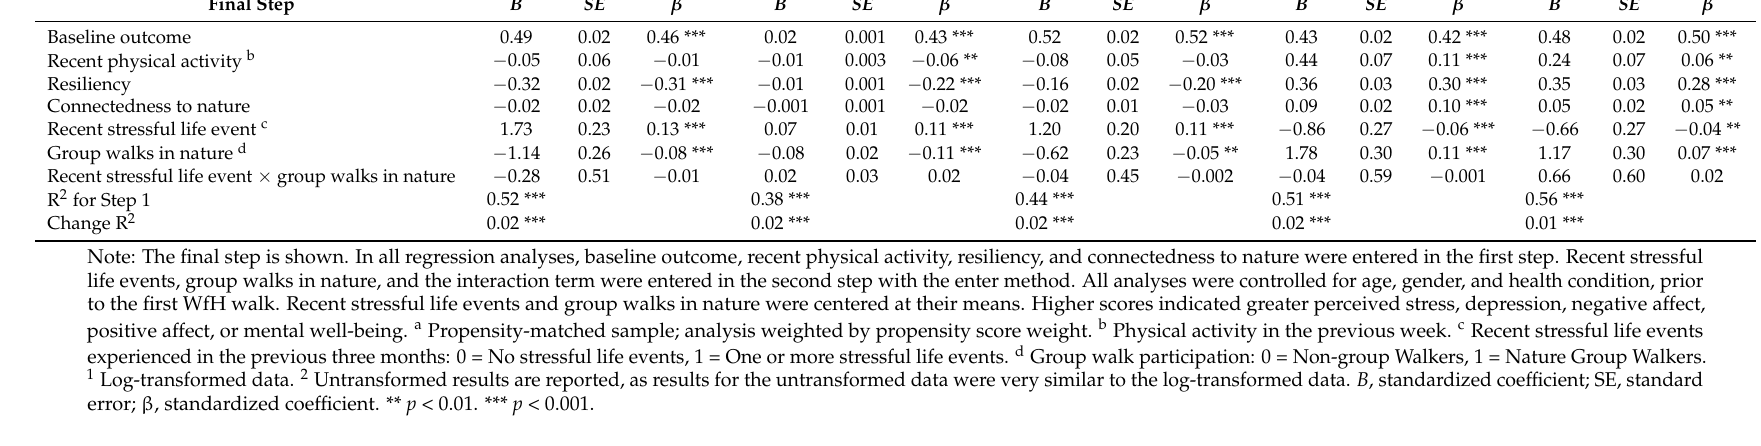
Table 4. A main effects model assessing the effect of group walks in nature and recent stressful life events on perceived stress, depression, negative affect, positive affect, and mental well-being. Main sample ( n = 1506 a